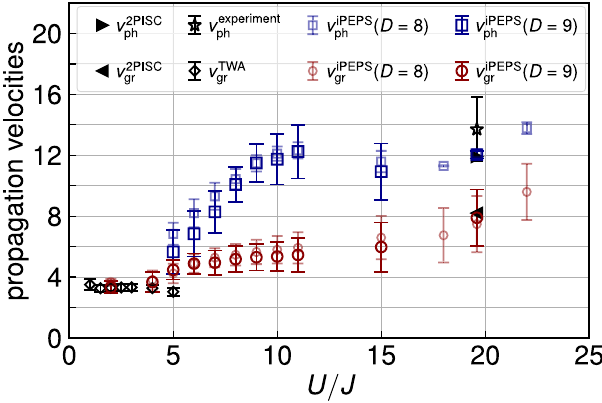
Fig. 5 Propagation velocities as functions of the ratio between the interaction ( U ) and hopping ( J ) strengths. The group ( v gr , red circles) and phase ( v ph , blue squares) velocities are estimated from the density – density and single-particle correlation functions for the bond dimensions D = 8 and D = 9 using the in fi nite projected entangled pair state (iPEPS) algorithm. The data for D = 8 and D = 9 overlap within the error bars. The velocities and their error bars are obtained by extrapolation of the distance dependence of the peak time. The results obtained by the two-particle irreducible strong-coupling (2PISC) approach 15 (triangles), the truncated Wigner approximation (TWA) 13 (diamonds), and the experiment 3 (a star) are shown. Both velocities gradually merge with decreasing